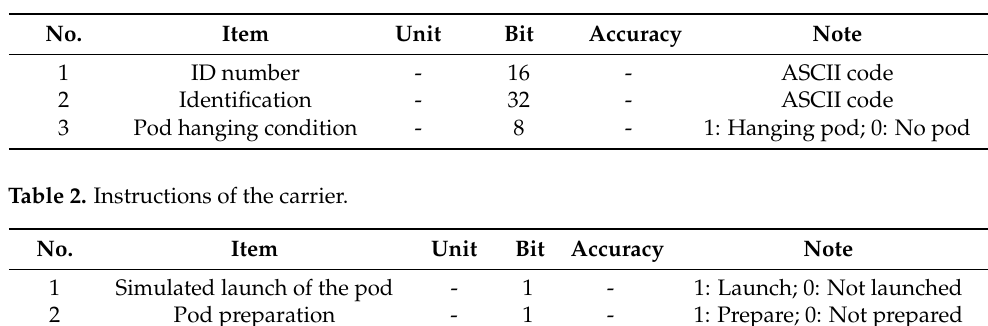
Table 1. Description of the carrier.